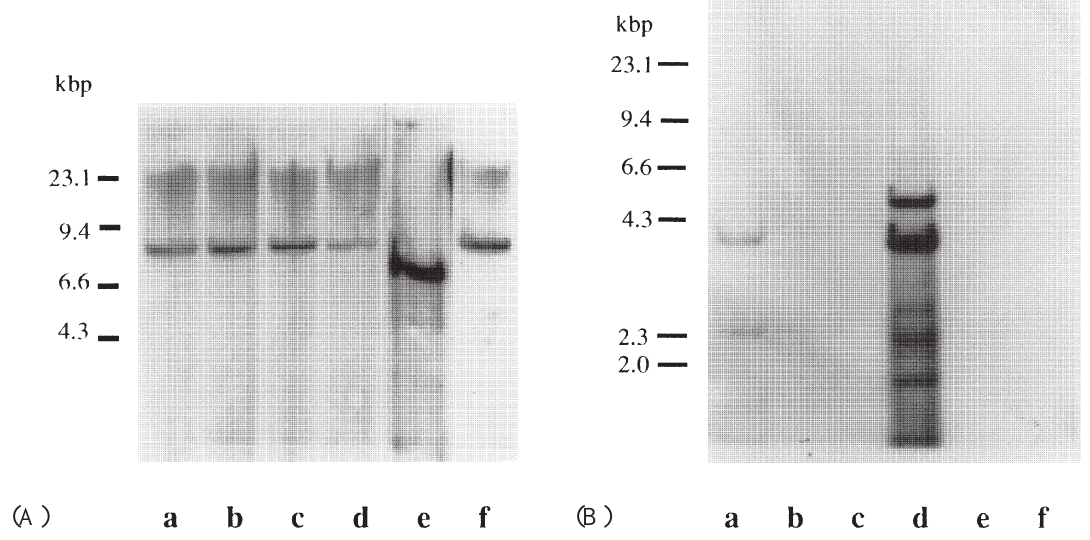
Fig. 1. Southern blot hybridization of oral lesion DNA in case 2 with HPV DNA probe(s). (A) DNA was digested with Bam HI and hybridized with a mixed 32 P-labeled probe containing HPVs 2a, 6b, 11, 16 and 18 DNA under low stringency conditions (lane e). Lanes a, b, c, d and f show one copy positive marker of each of the above HPV types at full length linear state. (B) DNA in case 2 was digested with both Eco RI and Pst I, and hybridized with linear 32 P-labeled HPV 2a probe under high stringency conditions (lane d). Lanes a, b, c, e and f were Pst I digested DNA of full length linear HPVs 2a, 6b, 11, 16 and 18 DNA, respectively. Bars at the left show the pattern of lambda DNA digested with Hind III as size